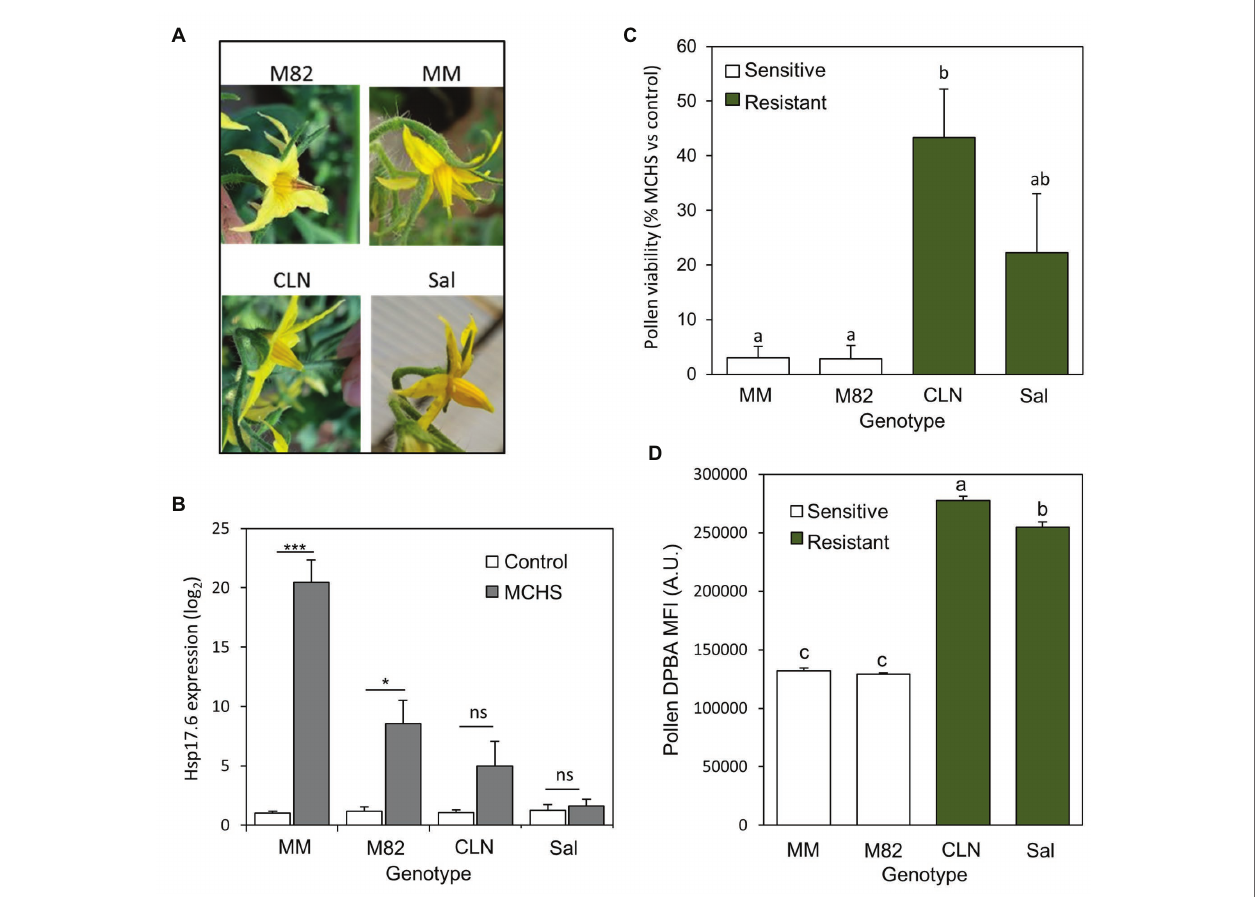
FIGURE 6 | Flavonols levels are higher in pollen of heat stress tolerant tomato cultivars. (A) Typical flower appearance in response to heat stress in each of the four cultivars. (B) Expression level of the heat stress molecular marker gene Hsp17.6 in leaves of the four genotypes, under control and MCHS conditions. (C) Pollen viability rates of the four genotypes under MCHS conditions, relative to control conditions. Pollen viability rates were 96–97% in all four genotypes, under control conditions, therefore used as a reference to present the stress effect. (D) Pollen flavonols in the four genotypes, measured by diphenylboric acid-2-aminoethyl ester (DPBA) mean fluorescence signal intensity (MFI), in arbitrary units. Error bars represent SEM. *represents p < 0.05 and ***represents p < 0.001. Different letters indicate statistically significant differences. MCHS, moderate chronic heat stress; MM, moneymaker; CLN, CLN1621; Sal, saladette; and AU, arbitrary